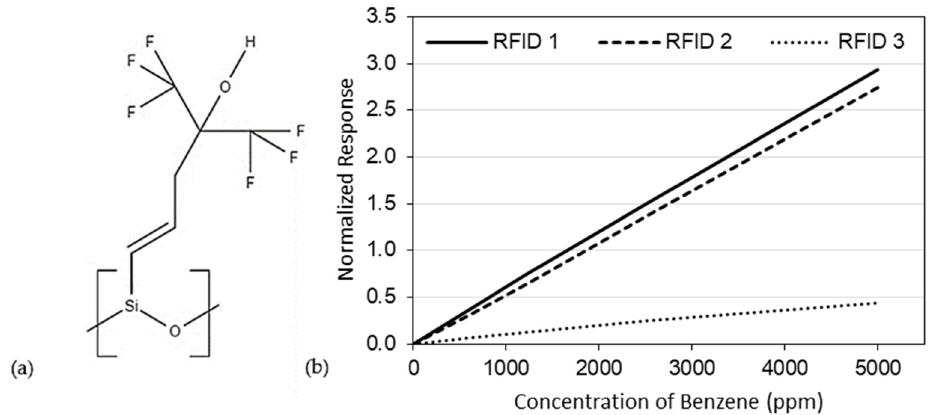
Figure 1. ( a ) Chemical structure of SXFA and ( b ) Normalized response to benzene of three different RFID sensors using SXFA as a sensing material [14,15] (RFID: radio frequency identification).